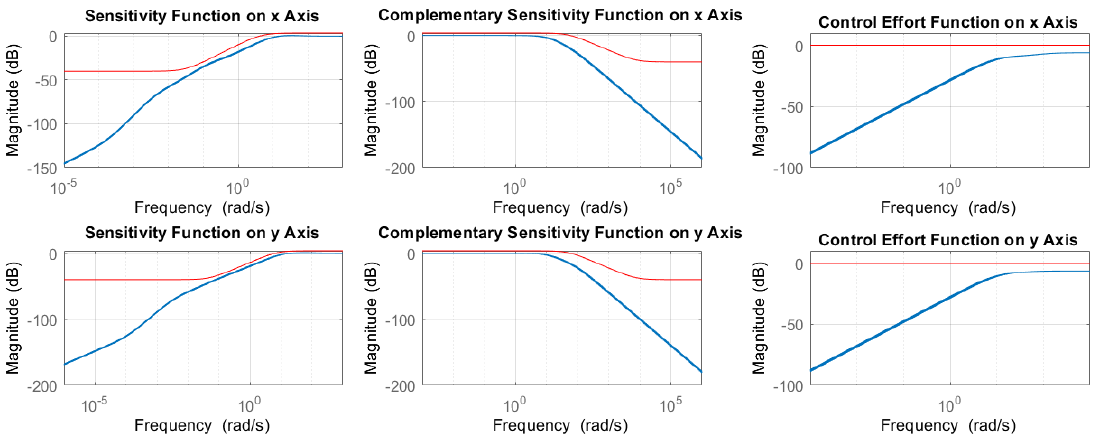
Figure 4. Imposed shapes of the sensitivity, complementary sensitivity and control effort frequency responses for both axis, along with 100 Monte Carlo simulations with FO - PID closed-loop systems.